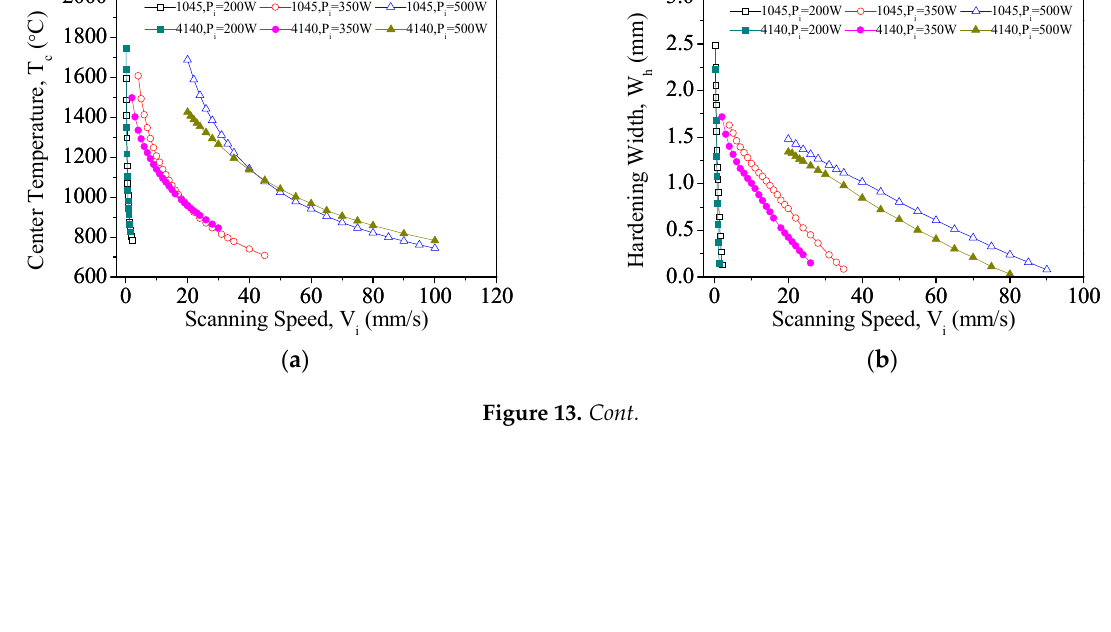
Figure 12. Temperature distributions induced by different scanning speeds during single-track laser heat treatment. (a) AISI 1045, V i = 10 mm/s, P i = 350 W; (b) AISI 4140, V i = 10 mm/s, P i = 350 W; (c) AISI 1045, V i = 25 mm/s, P i = 350 W; (d) AISI 4140, V i = 25 mm/s, P i = 350 W; (e) AISI 1045, V i = 40 mm/s, P i = 350 W; and (f) AISI 4140, V i = 40 mm/s, P i = 350 W.